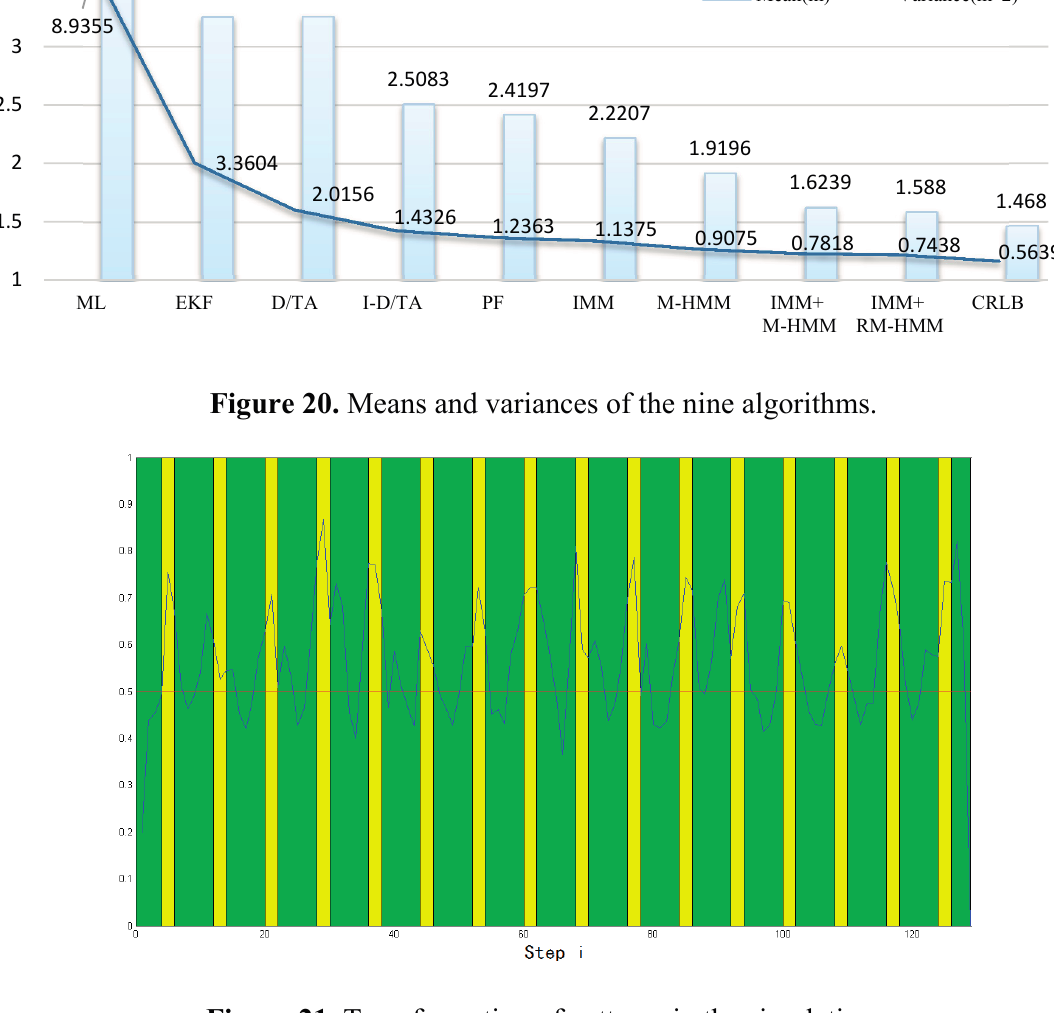
Figure 21. Transformation of patterns in the simulation.